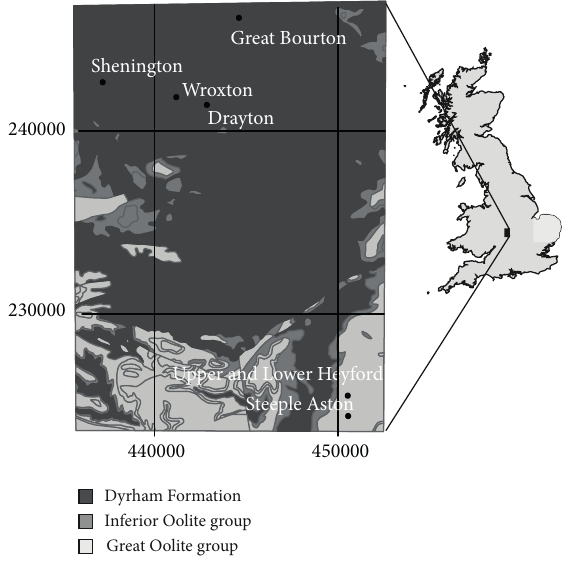
Figure 1: Local geology for the study